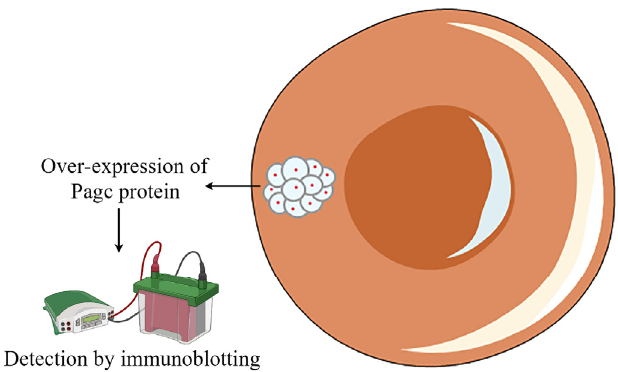
Figure 7. Schematic diagram of the biomarker testing method (protein).